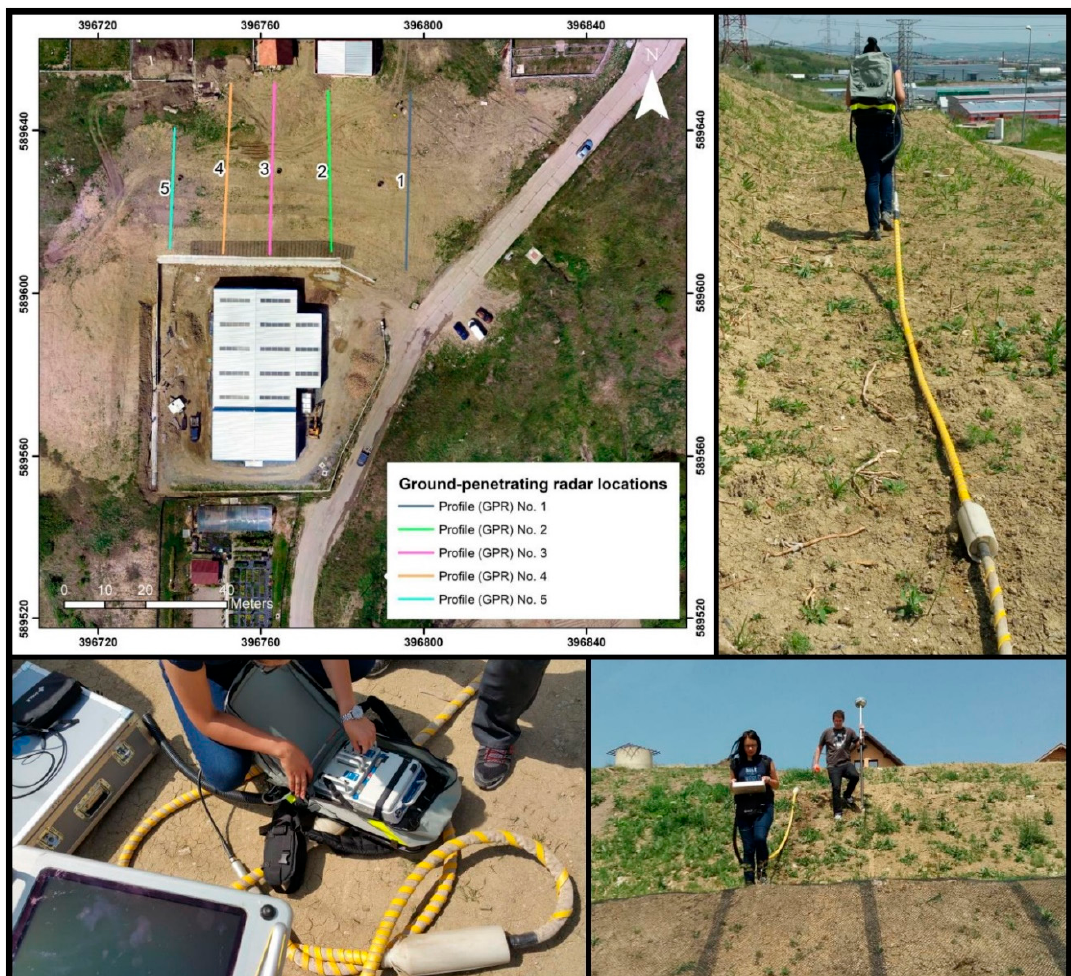
Figure 10. Obtained orthophoto with GPR profile locations and the instrumentation used.